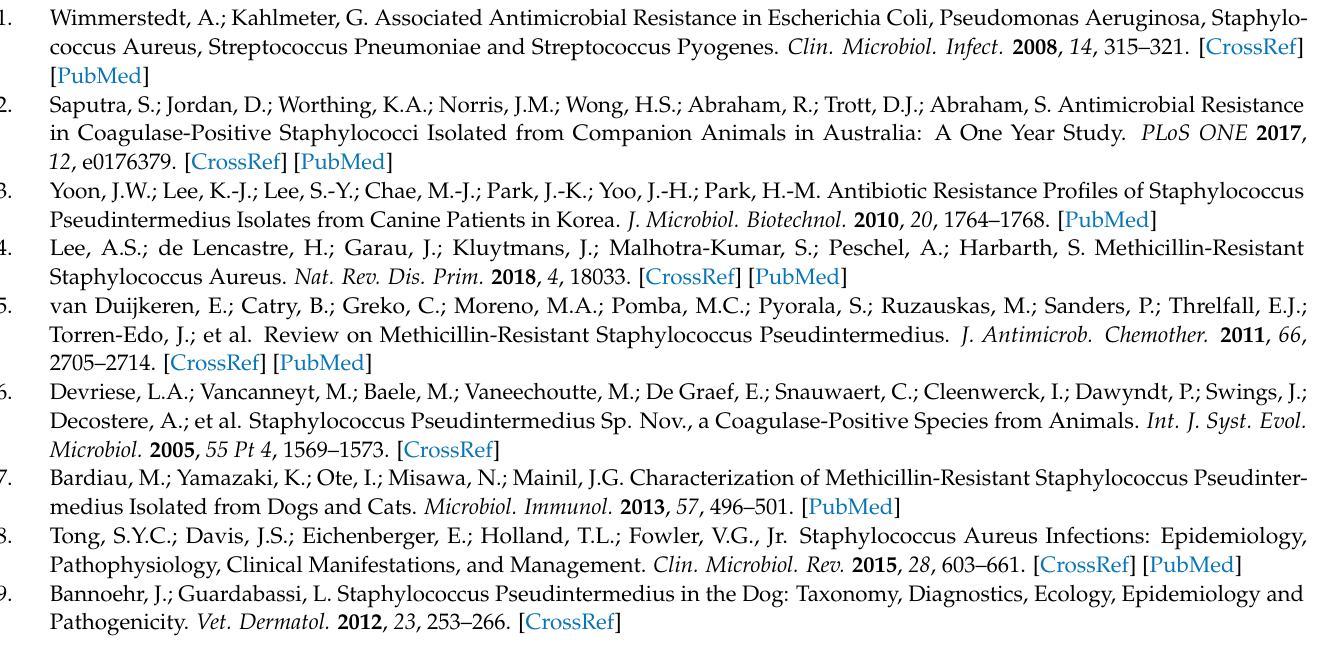
Supplementary Materials: The following are available online at https://www.mdpi.com/article/10 .3390/vetsci8090177/s1, Table S1: Inhibition zone diameter of AgNP gel (S1–S3) and povidone iodine against two species of human pathogens and animal pathogen (five isolates of S. pseudintermedius ), Table S2: Comparison of the inhibition zone diameter of AgNP gel (S1–S3) with povidone iodine after the antimicrobial agents were incubated with bacteria for 48 h. Figure S1: Cell morphological change of S. pseudintermedius MIC 411 observed by FIB-FESEM. The bacterial cells were treated at concentration of MBC level for 1.5 h with AgNSs (a), and anisotropic AgNPs (b). Bacterial cell treated AgNPs show the distorted cell and membrane damage with disintegration and